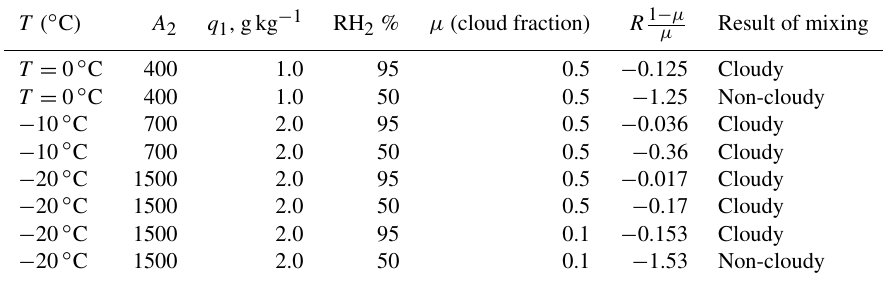
Table 2. Estimations of mixing results at different environmental conditions ∗ .